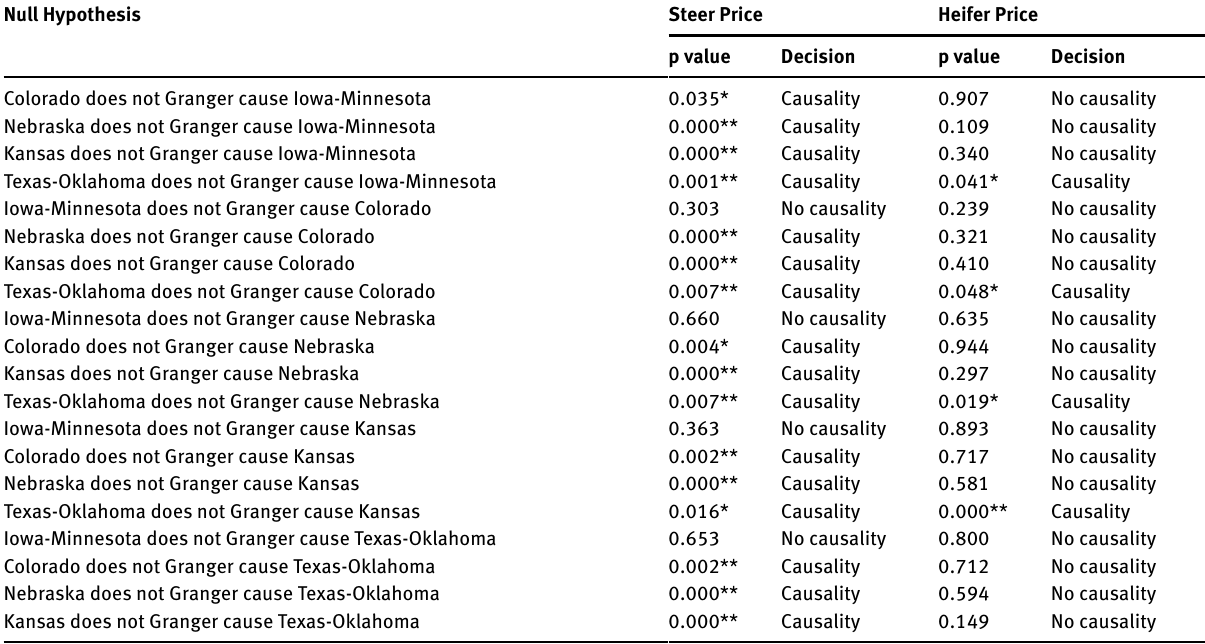
Table 5: Granger Causality Test for Live Steer and Heifer Price Series Null Hypothesis Steer